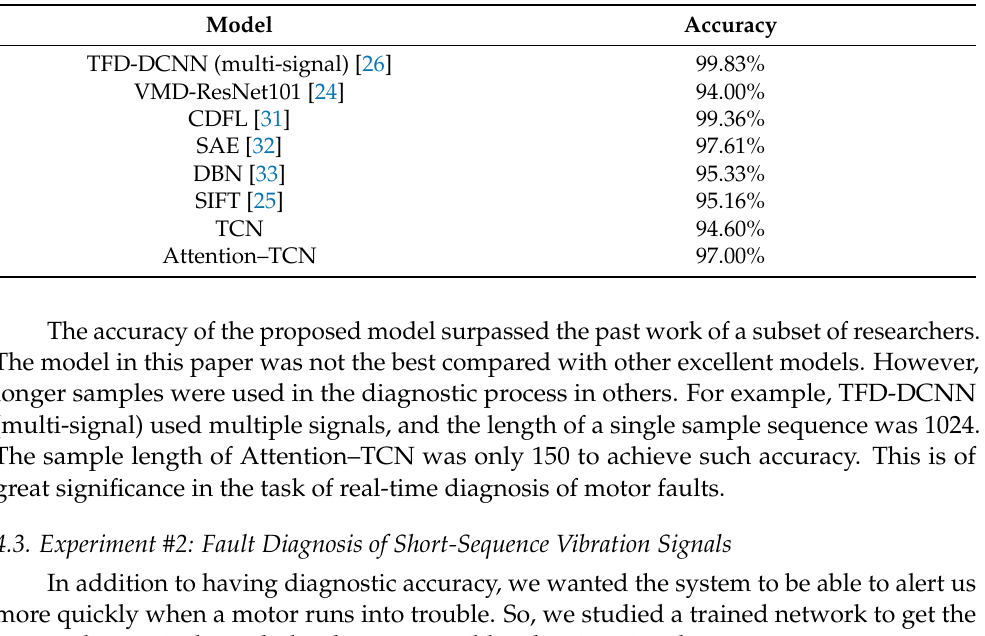
Table 2. Comparison of deep learning model in motor fault diagnosis.